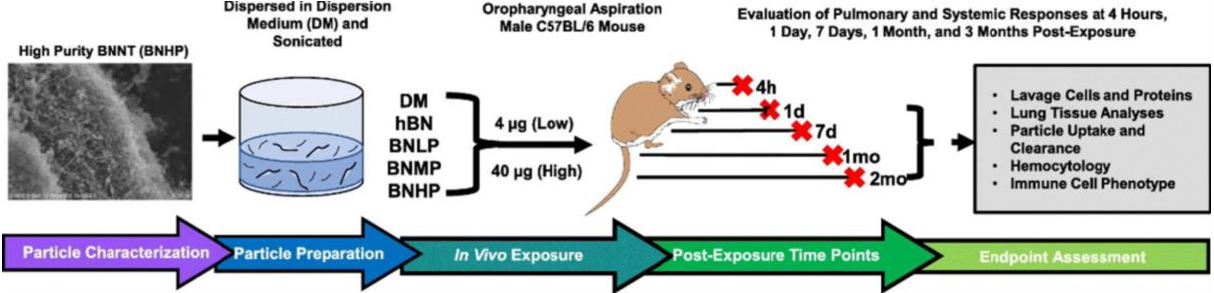
Figure 9. Overview of the BNNTs toxicity investigation following pulmonary exposure in mice. Reproduced with permission from Ref [29]. Copyrights 2020, Elsevier.